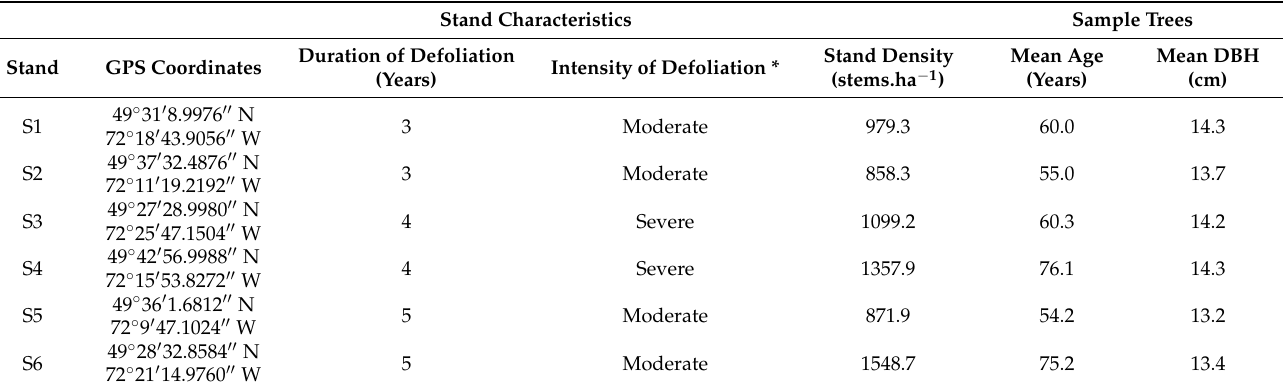
Table 1. Characteristics of the six stands sampled and mean age and DBH of the trees sampled in each stand. Stand Characteristics Sample